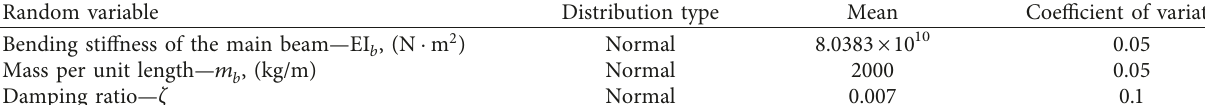
Table 1: Properties of structural random variables.